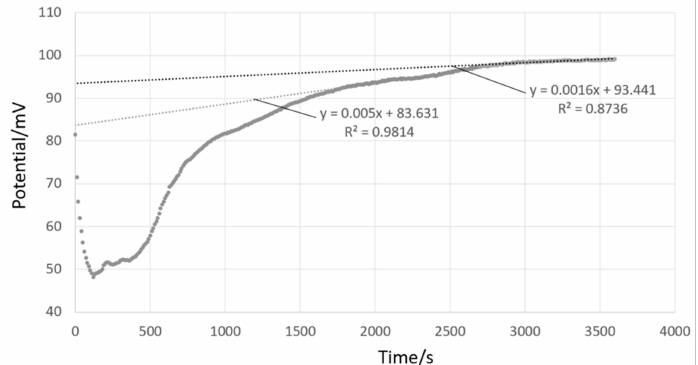
Figure 1. Potential difference measured at DFM with Cell I using 2 SCGE (electrode A) between an ethanol mixture (70 wt% ethanol—30 wt% water) and an acetonitrile mixture (76 wt% acetonitrile— 24 wt% water). The final 30 min of data are divided into two 15 min increments, and the extrapolation to t = 0 is shown for each